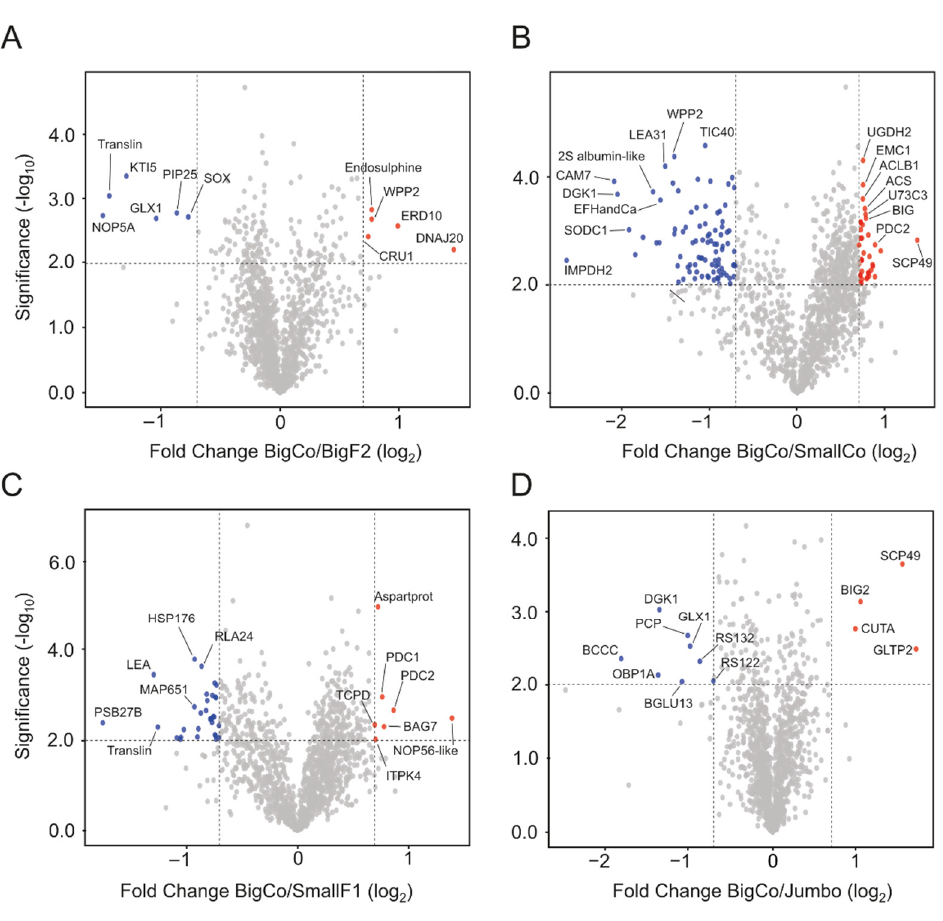
Figure 2. Representation of protein abundances in volcano plots based on different log2 ratios (( A ), BigCo/BigF2; ( B ), BigCo and SmallCo; ( C ), BigCo and SmallF1; ( D ), BigCo and Jumbo) and significant values ( p -value − log10). Each figure shows the most significant differential proteins. In ( A ), Kunitz trypsin inhibitor 5 (KTI5), Translin family protein, probable nucleolar protein 5-1 (NOP58), lactoylglutathione lyase 1 (GLX1), probable aquaporin PIP2-5 (PIP25), sulfite oxidase (SOX), chaperone protein (DNAJ20), dehydrin (ERD10), endosulphine (Q93Z49), WPP domain-containing protein 2 (WPP2), and 12S seed storage protein CRA1 (CRU1). In ( B ), calmodulin 7 (CAM7), diacylglycerol kinase 1 (DGK1), inosine-5 (cid:48) -monophosphate dehydrogenase 2 (IMPDH2), late embryogenesis abundant protein 31 (LEA31), WPP2, TIC40, 2S albumin- like (A0A1S2XDF0), calcium-binding EF-hand family protein (EFHandCa), superoxide dismutase Cu-Zn 1 (SODC1), serine carboxypeptidase-like 49 (SCP49), UDP-glucose 6-dehydrogenase 2 (UGDH2), ATP- citrate synthase beta chain protein 1 (ACLB1), ER membrane protein complex subunit 1 (EMC1), acetyl- coenzyme A synthetase (ACS), UDP-glycosyltransferase 73C3 (U73C3), and auxin transport protein (BIG). In ( C ), photosystem II D1 precursor processing protein (PSB27B), LEA, 17.6 kDa class II heat shock protein (HSP176), 60S acidic ribosomal protein P2-4 (RLA24), translin (A0A178W0K0), 65-kDa microtubule- associated protein 1 (MAP651), eukaryotic aspartyl protease family protein (Aspartprot), NOP56-like pre RNA processing ribonucleoprotein (NOP56-like), pyruvate decarboxylase 1 (PDC1), PDC2,